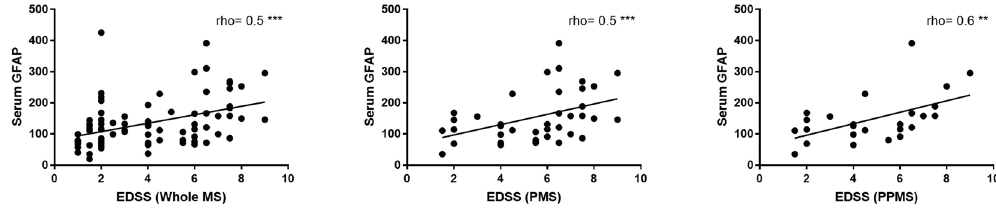
Figure 2. Spearman correlation (rho) between serum glial fibrillary acidic protein (GFAP) and expanded disability status scale (EDSS) in the whole multiple sclerosis (MS), progressive (PMS) and primary progressive (PPMS) patients. ** p < 0.01, *** p < 0.001.